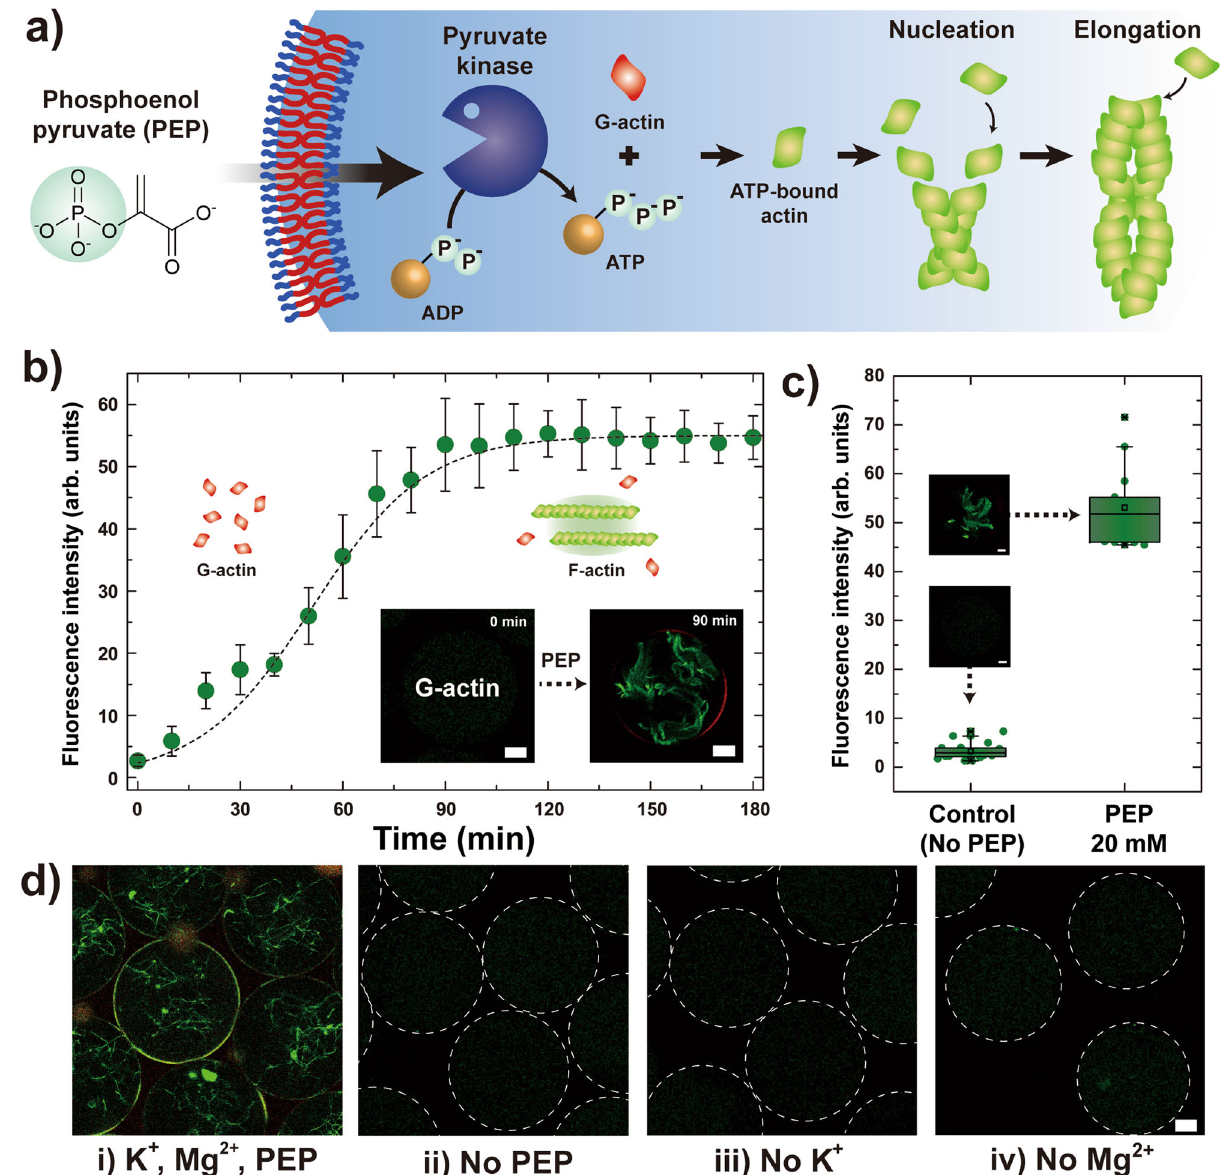
Fig. 5 | Signal-driven actin polymerization in polymersomes. a Schematics illustrating the PEP-driven actin polymerization in polymersomes. Globular actin (G-actin) is polymerized to become fi lamentous actin (F-actin) in the prescence of ATP. b Plot and schematic illustration showing the fl uorescence intensity change during the actin nucleation and elongation after PEP is infused as the signal. The F-actin and polymersome membrane are each stained with Alexa Fluor 488- phalloidin (green) and Nile Red (red), respectively ( n =14). The inset fl uorescence micrographs show actin elongation within the polymersome 90min after PEP infusion. Scale bar represent 20 µ m. Data are presented as mean values±standard deviation. c Plot showing the fl uorescence intensity of polymersomes 120min